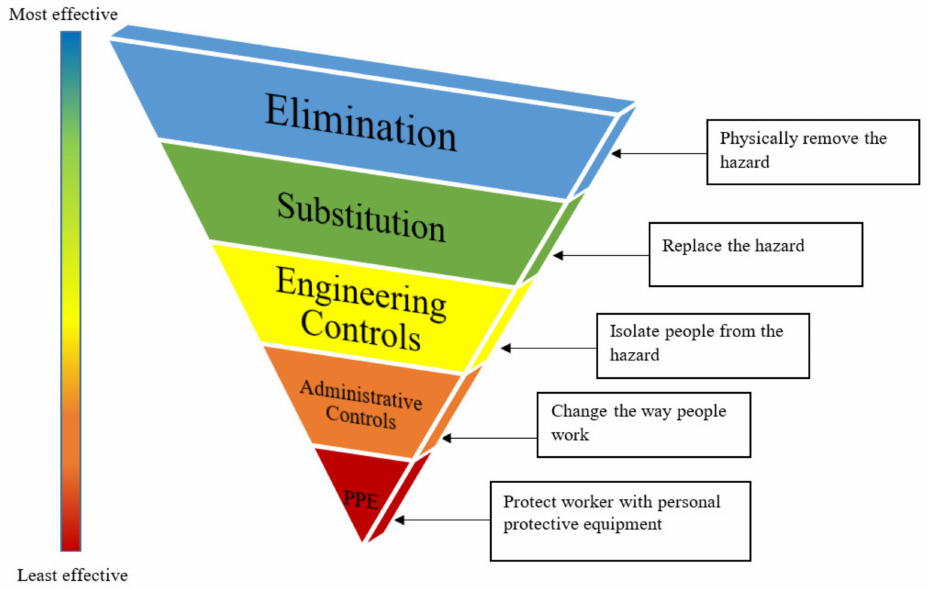
Figure 2. Schematic representation of the Hierarchy of Controls